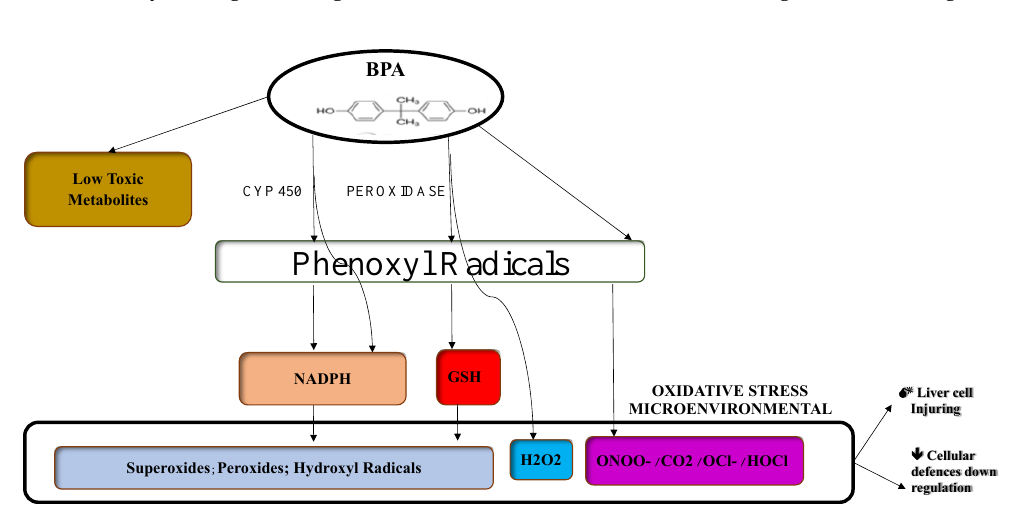
Figure 3. BPA-induced oxidative stress mechanisms.